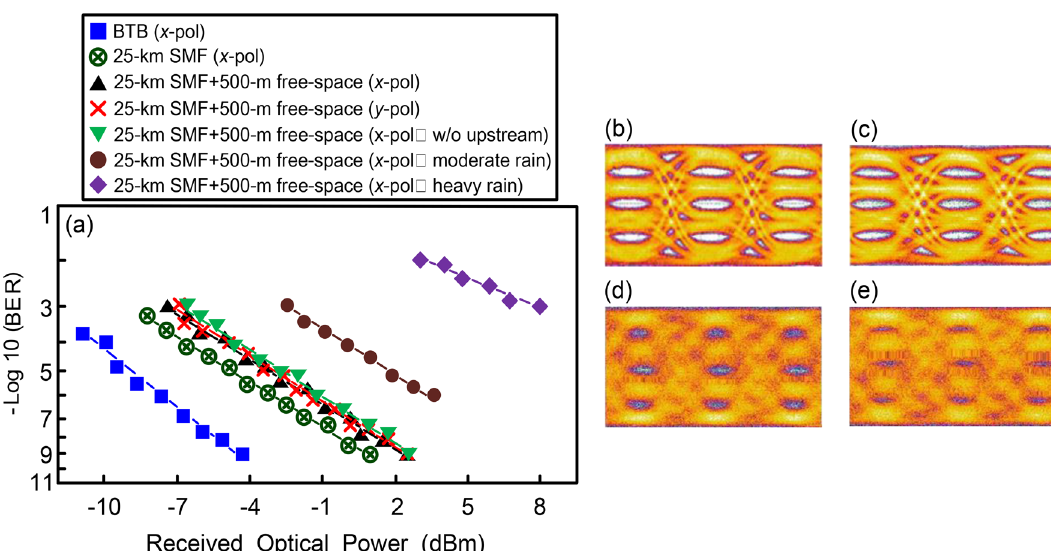
Figure 2. ( a ) The BER performances of 224 Gbit/s PAM4-based fibre-FSO converged system (downlink transmission) under different scenarios of back-to-back (BTB, x -polarisation), over 25-km SMF transport ( x -polarisation; sunny weather), over 25-km SMF transport with 500-m free-space transmission ( x - and y -polarisations; sunny weather), and over 25-km SMF transport with 500-m free-space transmission ( x -polarisation; moderate/heavy rain). The eye diagrams of 56 Gbit/s PAM4 signal in ( b ) BTB state ( x -polarisation) and that over 25-km SMF transport with 500-m free-space transmission ( x -polarisation) under ( c ) sunny weather, ( d ) moderate rain, and ( e ) heavy rain